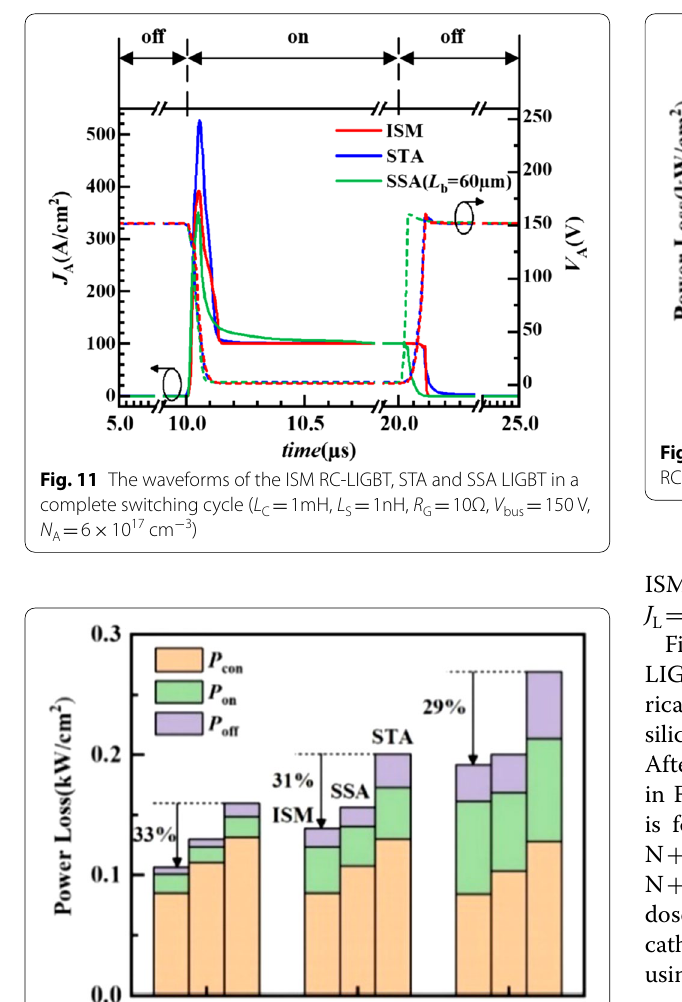
100A/cm 2 within 1 s =